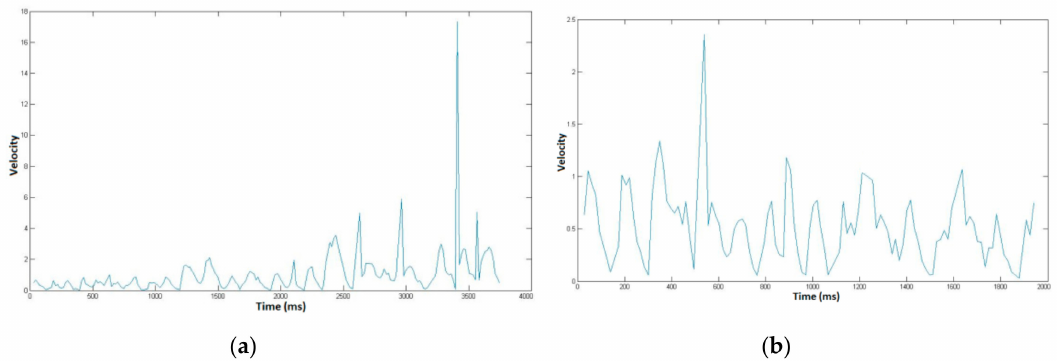
Figure 4. Velocity profile of ( a ) the forged usual signature and ( b ) the forged place information displayed in Figure